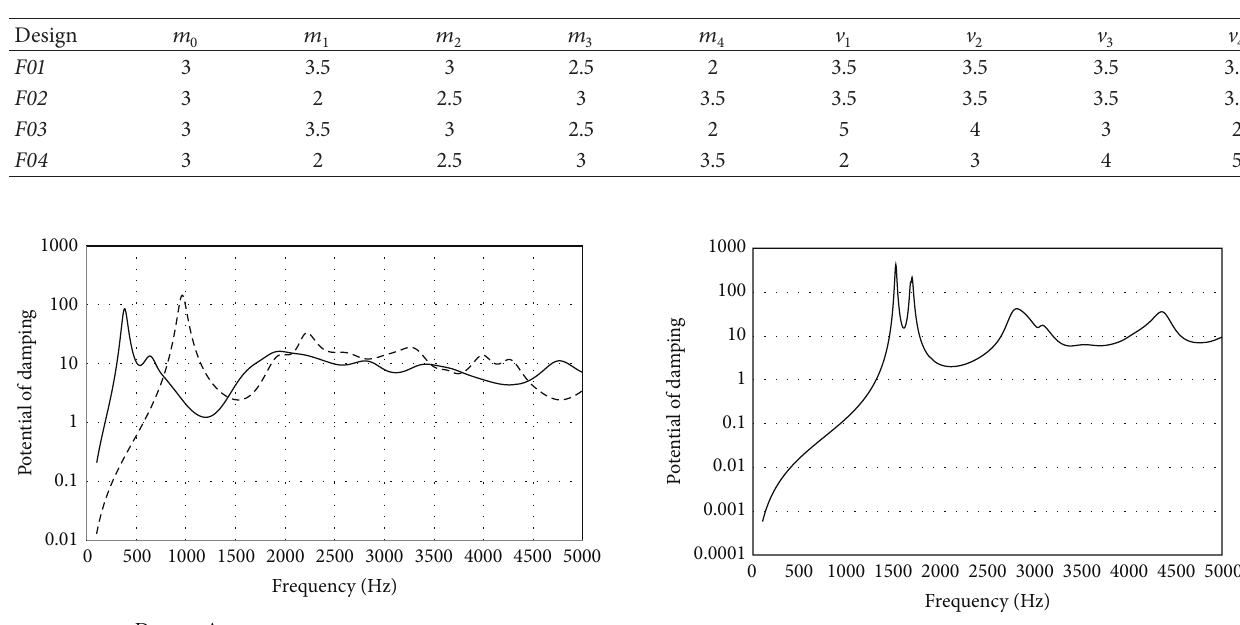
Table 12: Simulated four-layer sandwich-type CLD designs.